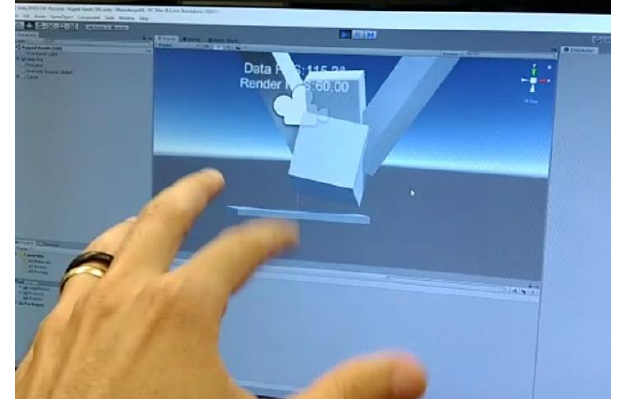
Figure 5. First Virtual Puppet system prototype in Unity3D.